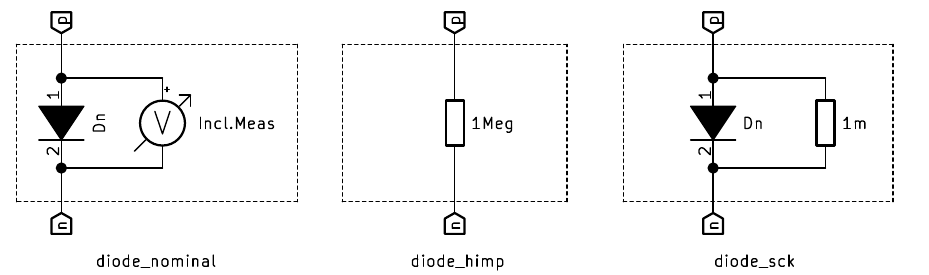
Figure 5. Rectifier diode failure modeling. ( Left ) The nominal model with inclusiveness measurement voltmeter. ( Center ) A high-impedance diode failure. ( Right ) A short-circuit diode